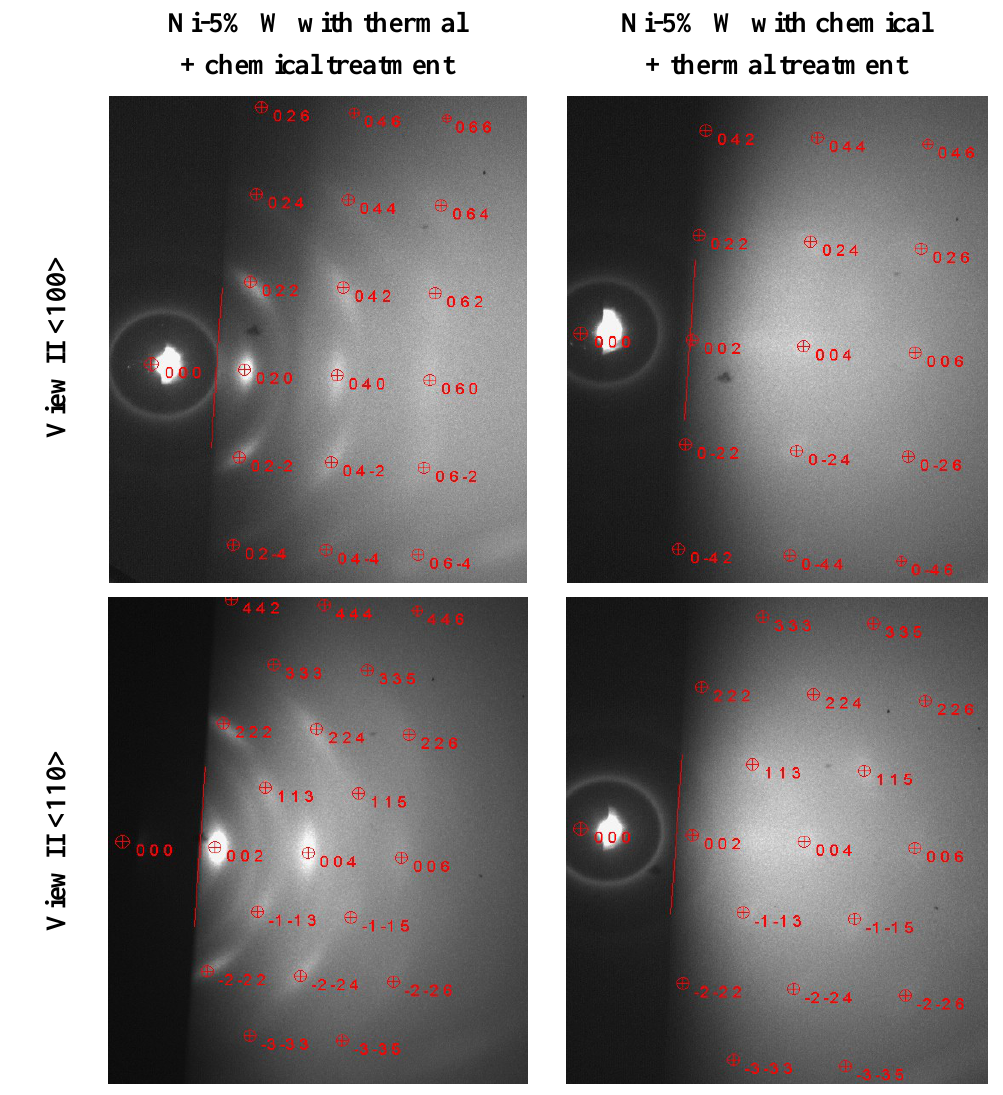
Figure 15. Comparison between the measured RHEED pattern and a simulation of the diffraction spots using NiO for sample with thermal followed by chemical treatment, whereas the pattern of the chemically followed by thermally treated substrate can be indexed with pure